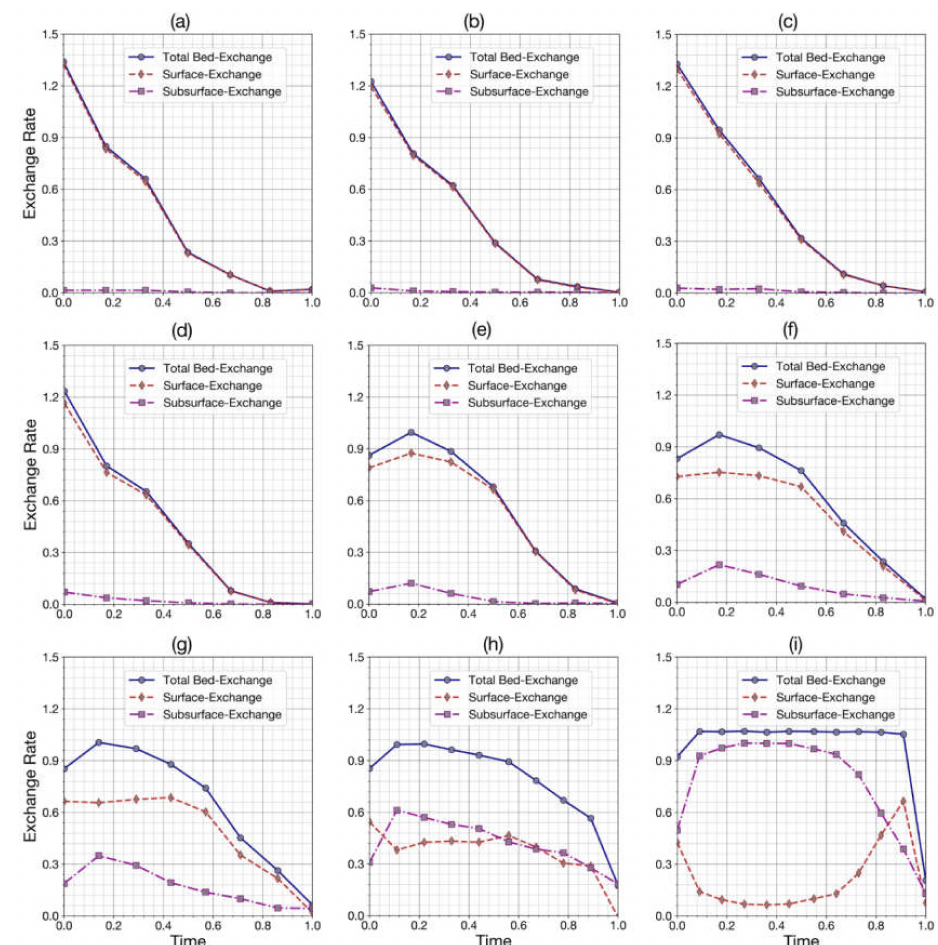
Figure 6. The dependence of exchange rate on the size ratio and the time ( a ) d / D = 0.45; ( b ) d / D = 0.414; ( c ) d / D = 0.40; ( d ) d / D = 0.35; ( e ) d / D = 0.30; ( f ) d / D = 0.25; ( g ) d / D = 0.20; ( h ) d / D = 0.154; ( i ) d / D =